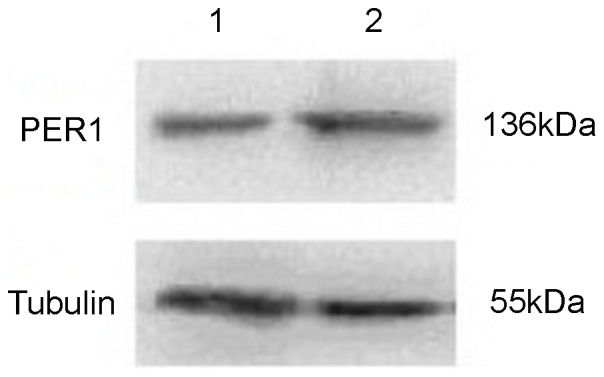
Western blot analysis of PER1 protein expression in tissues of patients with BSCC.The level of Tubulin in each sample is detected as an internal control. One representative of three independent experiments with similar results is shown. Lane 1: PER1 protein expression in cancerous tissues. Lane 2: PER1 protein expression in adjacent noncancerous tissues.